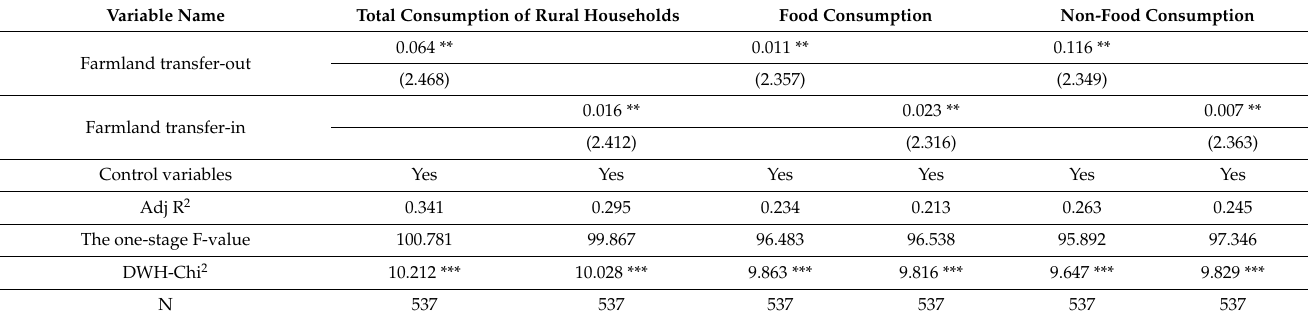
Table 7. Robustness test IV: Re-estimation using instrumental variables